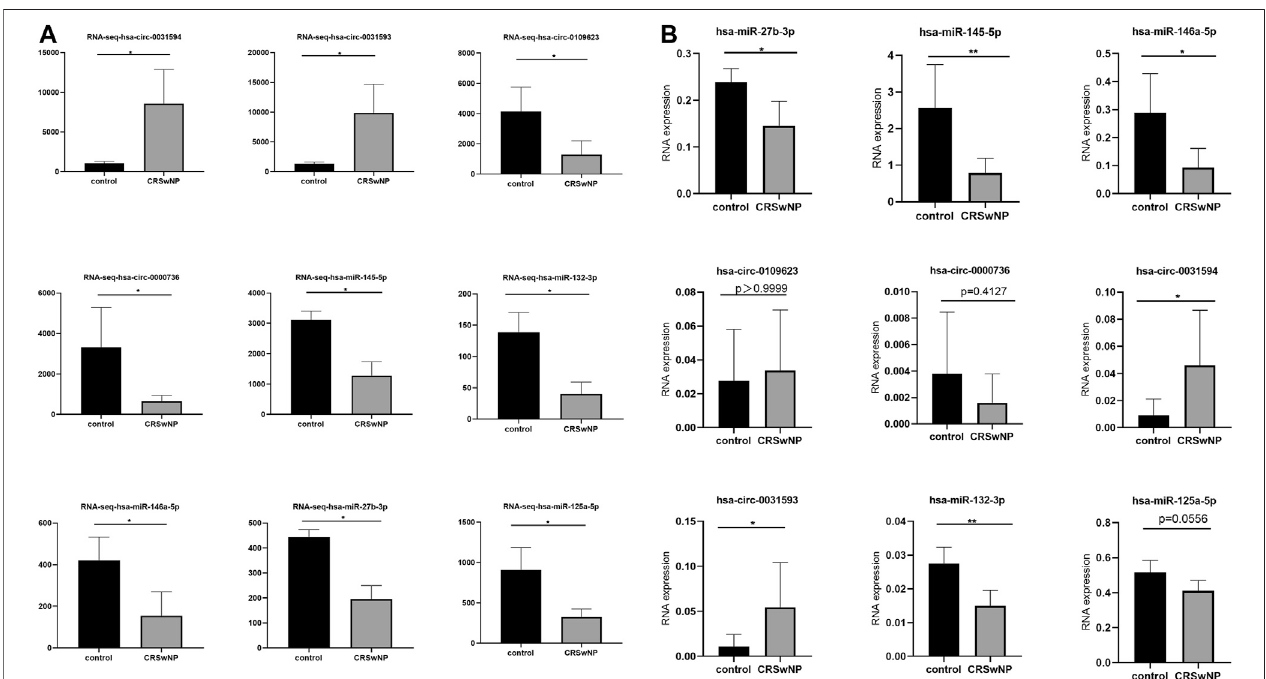
FIGURE 7 | Con fi rmation of the expression of circRNAs and miRNAs using RNA-sequencing and quantitative real-time polymerase chain reaction (qRT-PCR). CircRNAs and miRNAs were validated by RNA-sequencing (CRSwNP( n (cid:2) 6); control subjects ( n (cid:2) 3) (A) ; and qRT-PCR in an independent cohort of fi ve CRSwNP subjects and fi ve control subjects (B) . Each sample was detected in triplicate. GAPDH was used as the reference gene for circRNAs, and hsa-miR-16 was used as the reference gene for miRNAs. The relative expression levels of hsa-circ-0031593, hsa-circ-0031594, hsa-circ-0109623, hsa-circ-0000736, hsa-miR-132-3p, hsa- miR-145-5p, hsa-miR-146a-5p, hsa-miR-125a-5p, and hsa-miR-27b-3p by qRT-PCR. * p < 0.05, ** p < 0.01, *** p < 0.001, **** p <